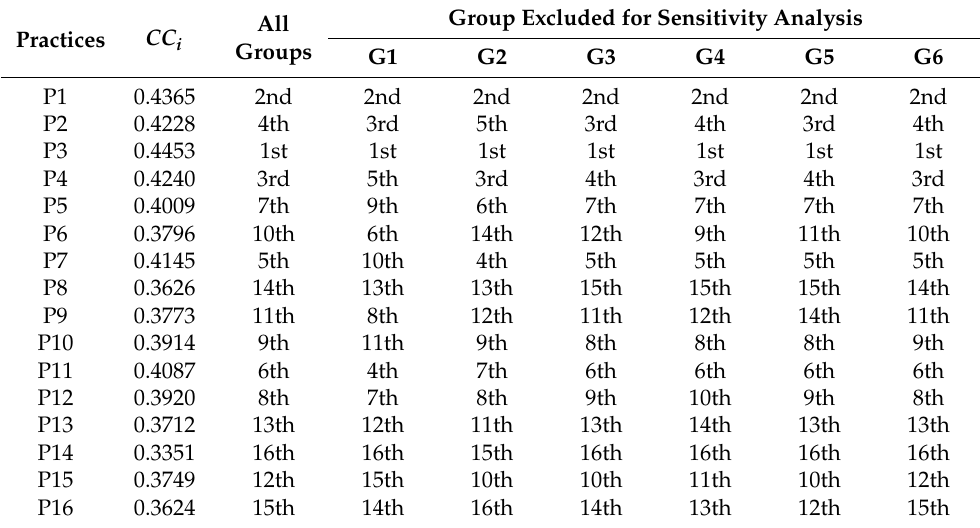
Table 5. The ordering of practices via Fuzzy TOPSIS and sensitivity analysis for LIs.